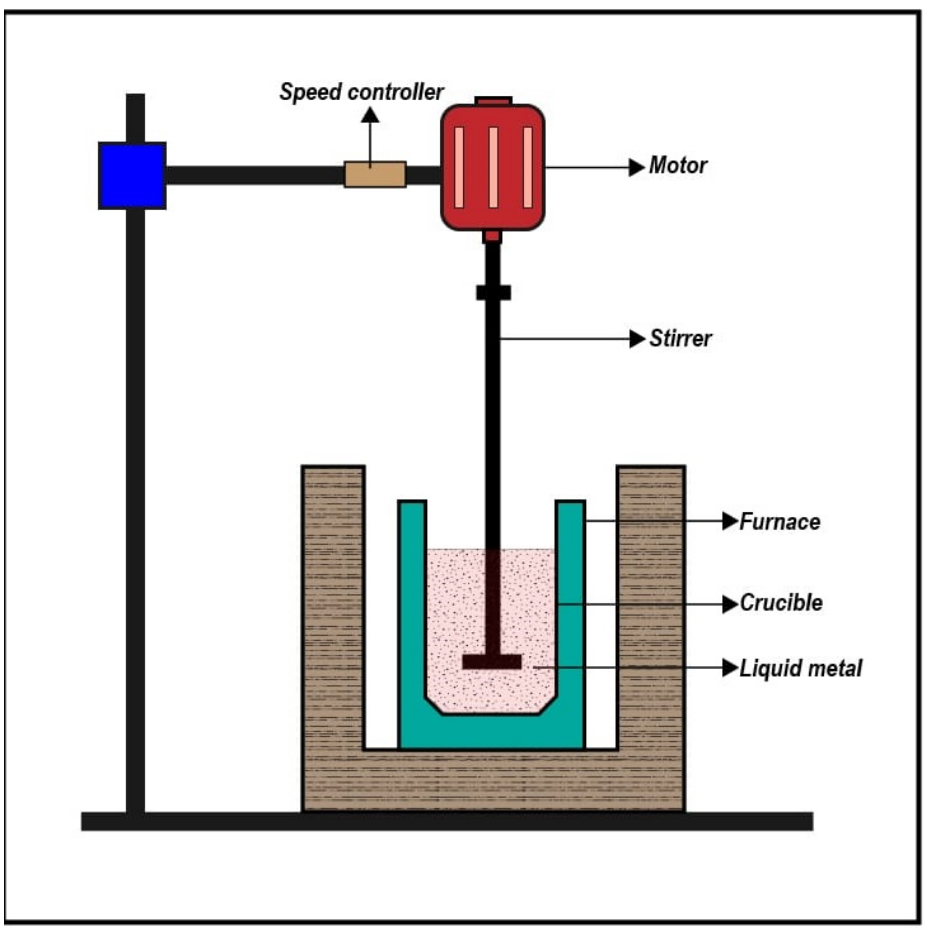
Table 1. Process parameters for stir casting.